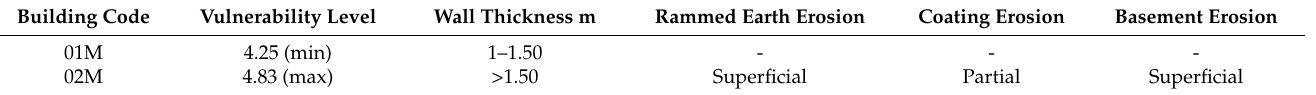
Table 10. Comparison of characteristics affecting the vulnerability of monumental earthen